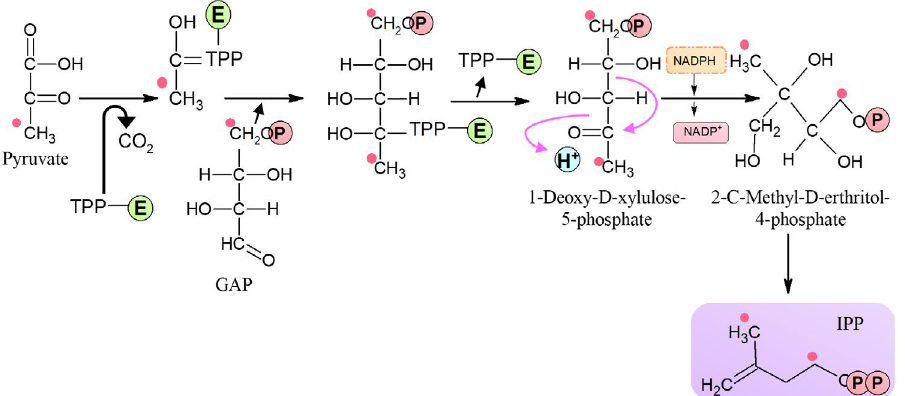
Fig. 2. Steps involved in the biosynthesis of terpenoids via MVA